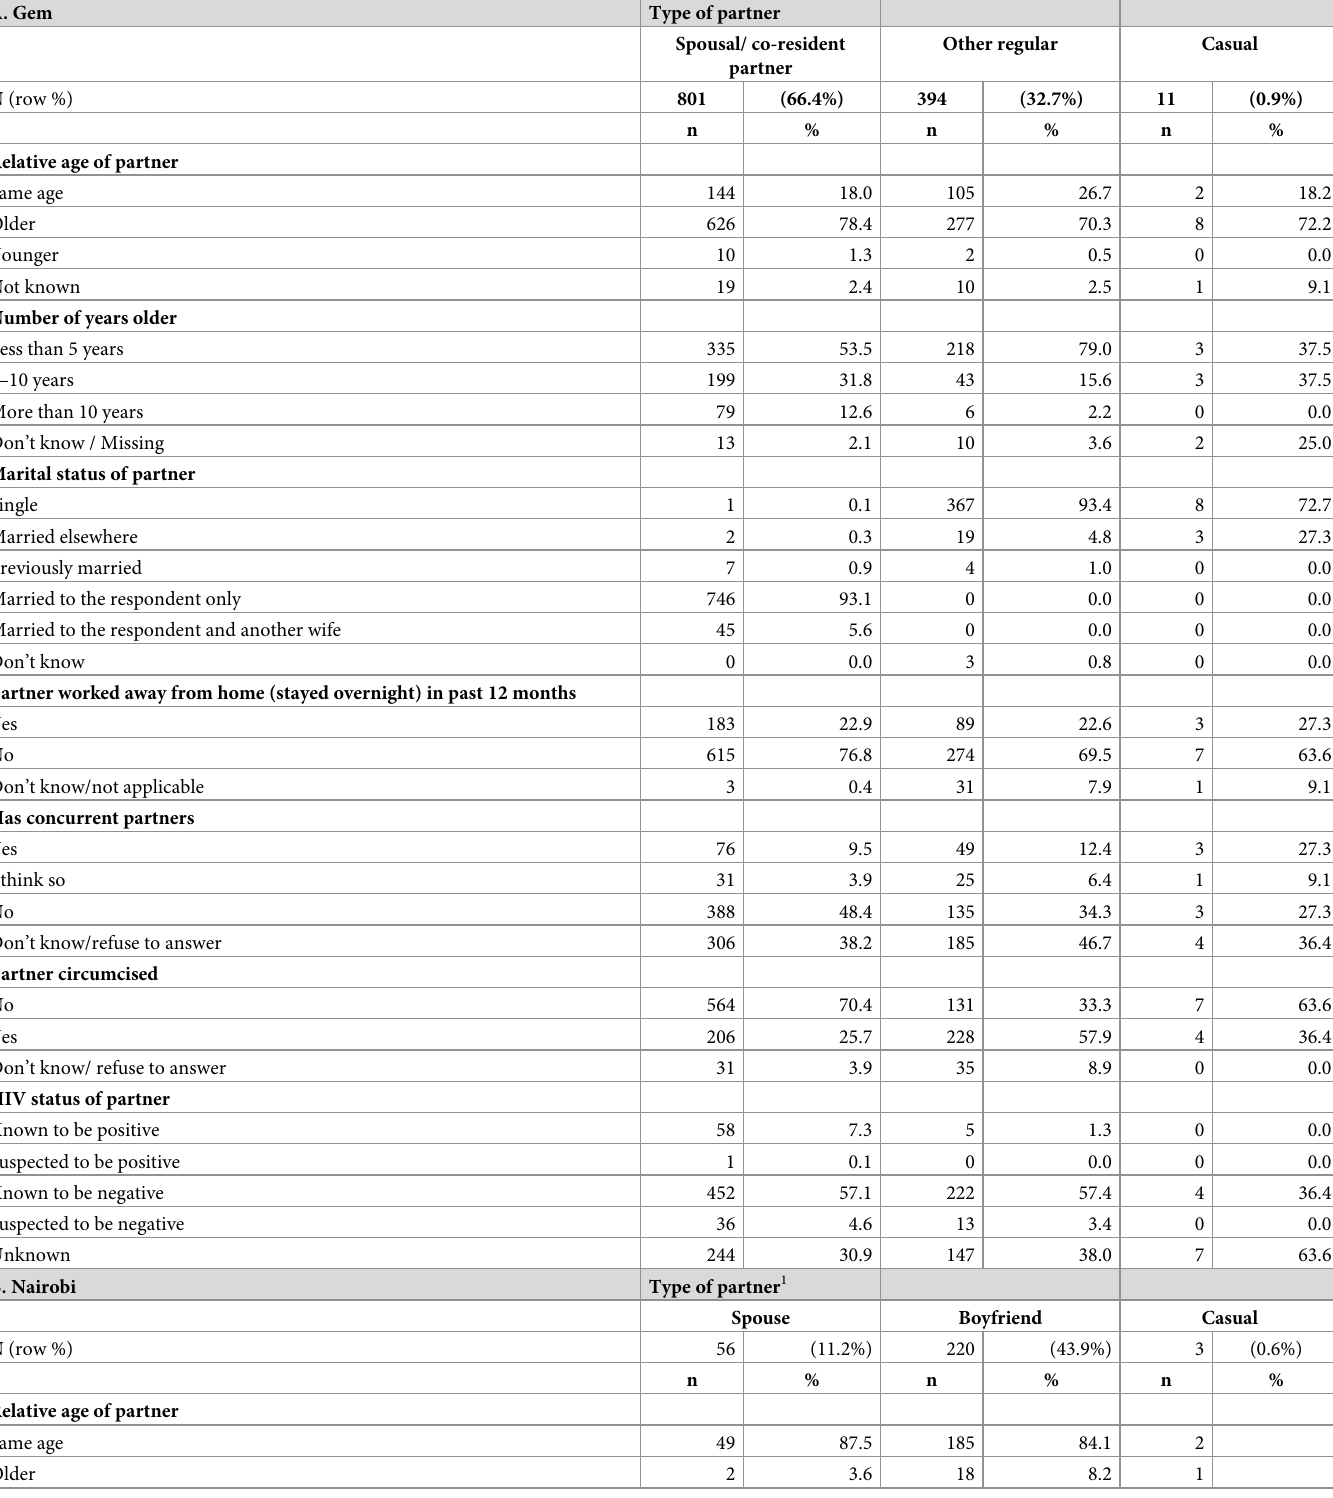
Table 5. Characteristics of male partners reported by AGYW in the past 12 months (unit = partner). A.